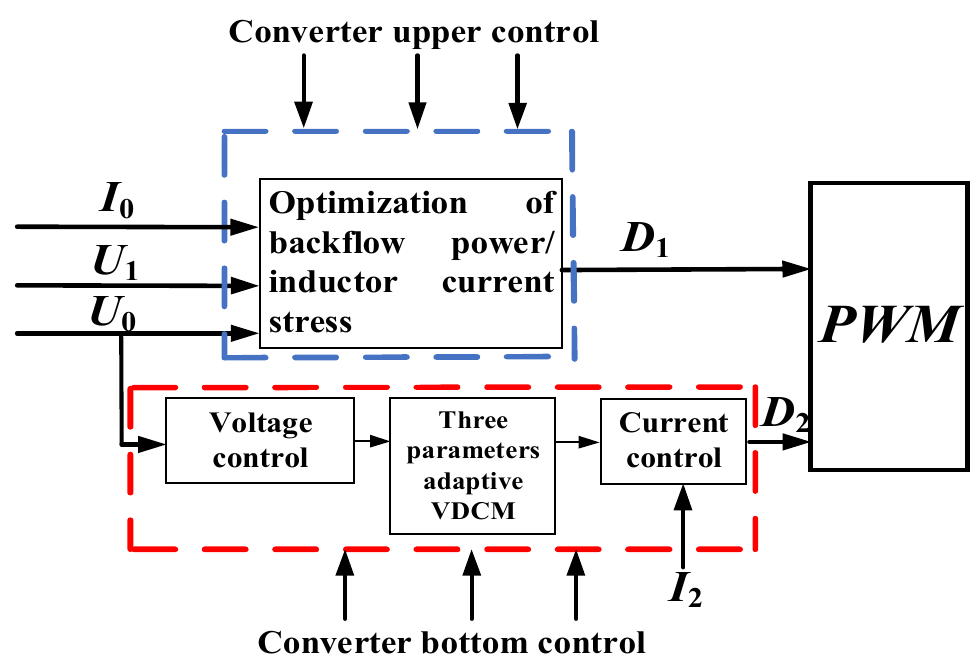
Figure 13. Converter control block